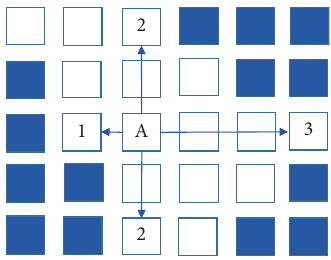
Figure 4: Gradation calculation of the random growth